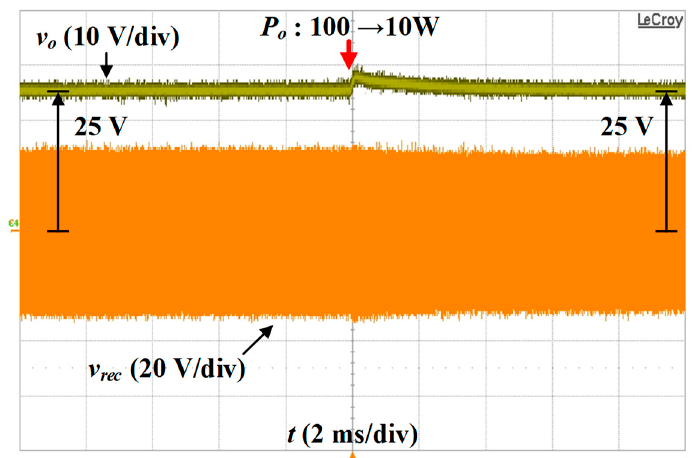
Figure 15. Transient response under load step from 100 W to 10 W.